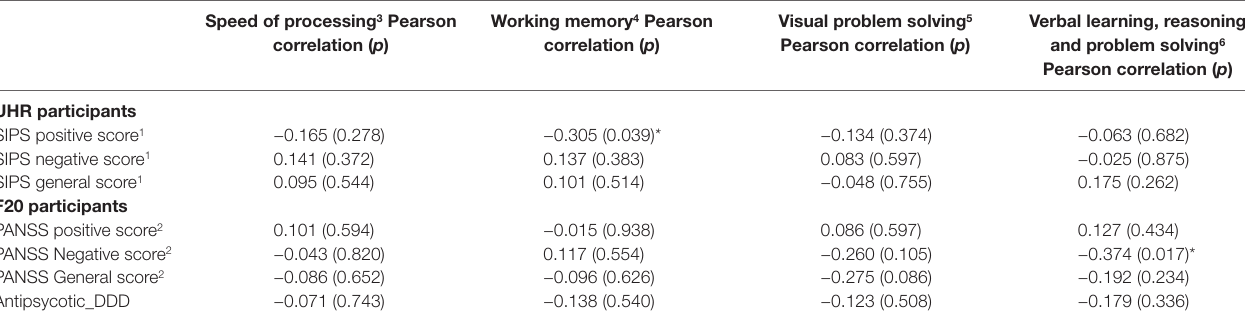
TABLE 3 | Correlations between cognitive domains and clinical